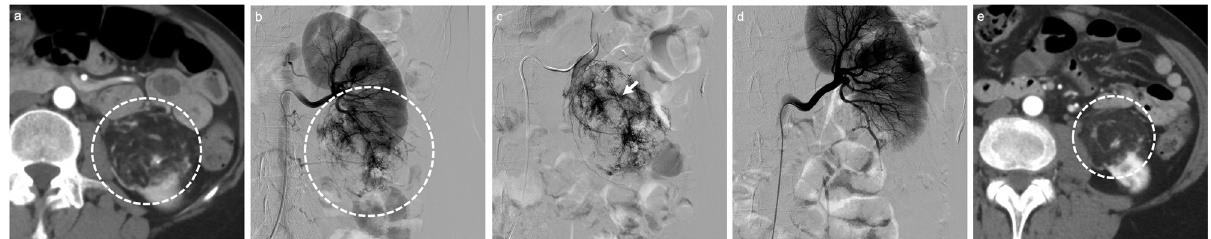
Figure 1: A 56 - year - old woman with left unruptured sporadic renal AML. ( a ) Contrast - enhanced CT showed AML in the left kidney ( circle ) . The size of the AML was 56 × 48 mm. ( b ) Enhancement of the AML ( circle ) was con fi rmed by angiography. ( c ) A microcatheter was advanced into the feeding artery of the AML ( arrow ) . Thereafter, TAE was performed through the microcatheter using 100 – 300 μ m microspheres. ( d ) Disappearance of enhancement of the tumor was con fi rmed. The renal infarction rate was < 10%. Slight pain occurred, but it improved with observation. ( e ) Contrast - enhanced CT 30 months after TAE showed shrinkage of the AML and the size was 44 × 33 mm ( circle ) . The shrinkage rate was